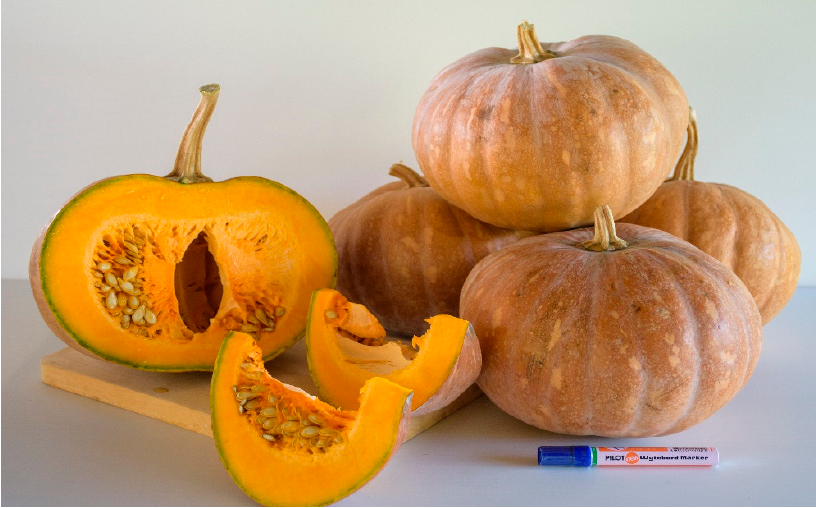
Figure 3. Fruit of SLCCNV, SLCPV-TW, and ToLCNDV resistant line AVPU1426.